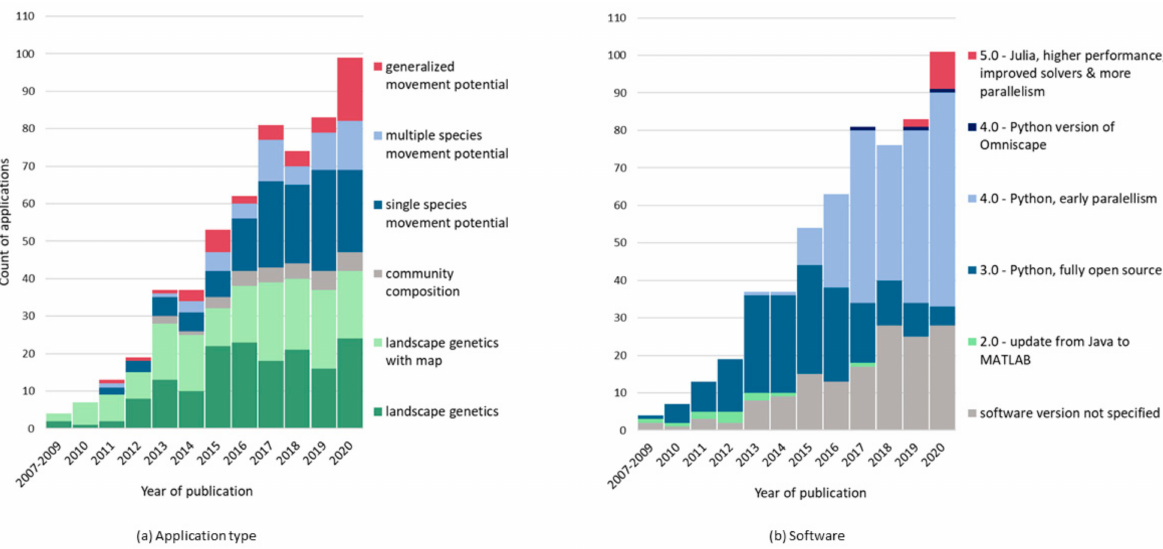
Figure 1. Count of Circuitscape applications in peer-reviewed journal articles by year, categorized by ( a ) type of application and ( b ) version of the software. Key milestones of each software version are indicated in the legend for ( b ). Graph ( a ) only includes genetic and movement-related applications (569); ( b ) includes 3 additional ecological applications, and one from materials sciences (573). A few studies used two versions of Circuitscape, and the count in ( b ) includes them under both software